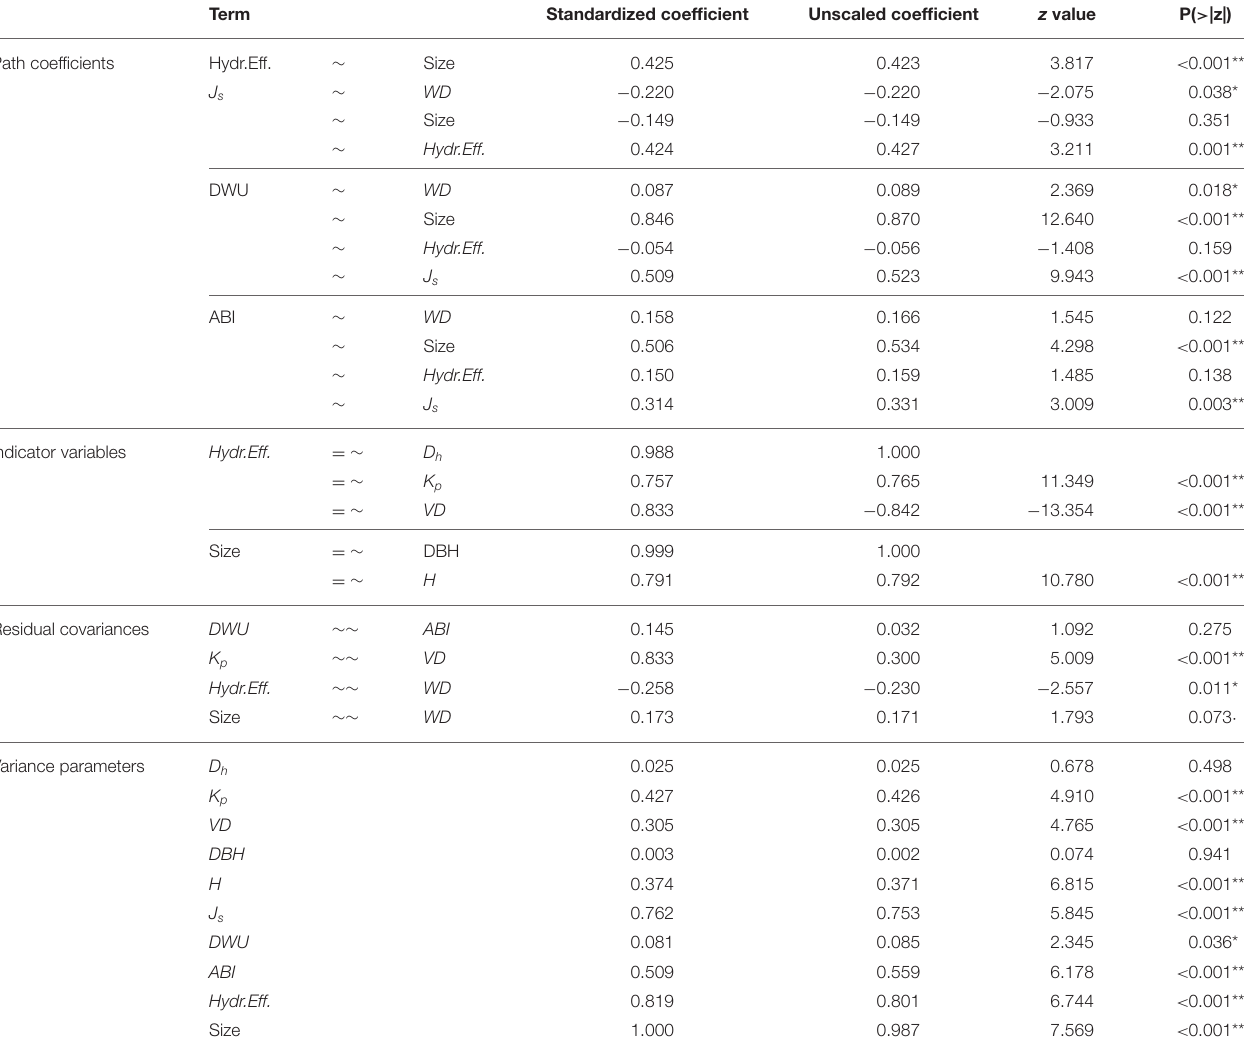
TABLE 2 | Estimated coefficients for the final path